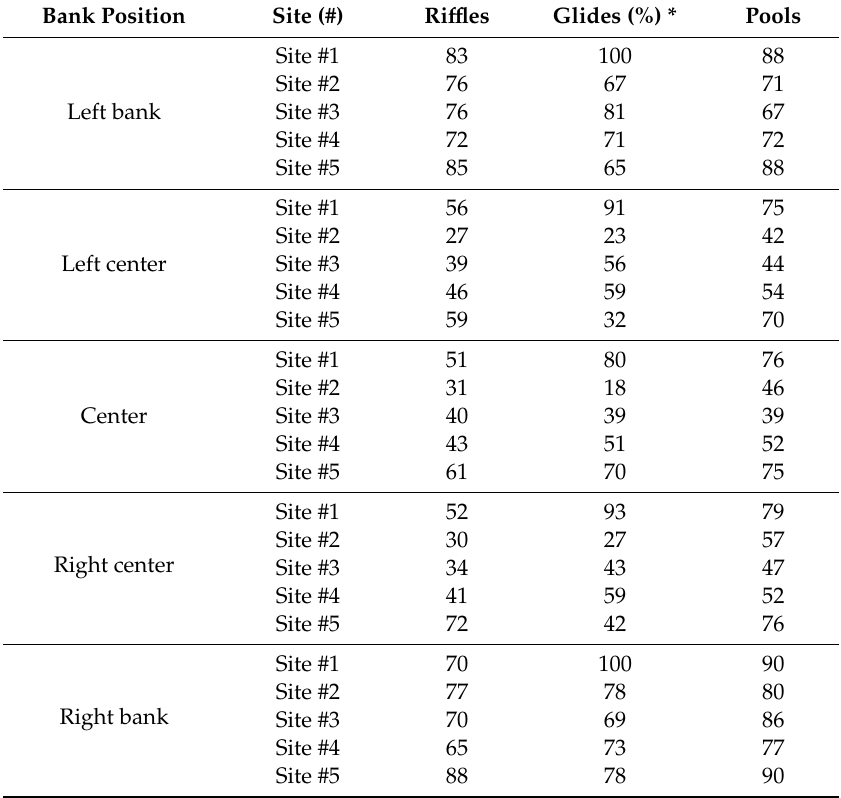
Table 6. Bank to bank variability of streambed substrate embeddedness in ri ffl es, glides, and pools measured at survey sites (n = 561) and averaged within five nested sub-basins located in Hinkson Creek Watershed, Missouri, USA. Each datum shows substrate embeddedness as a percent. Sub-basins were delineated between nested gauging sites, and thus, were not cumulative watersheds excepting Site #1 located in the headwaters. Bank Position Site (#) Ri ffl es Glides (%) * Pools Site Left bank